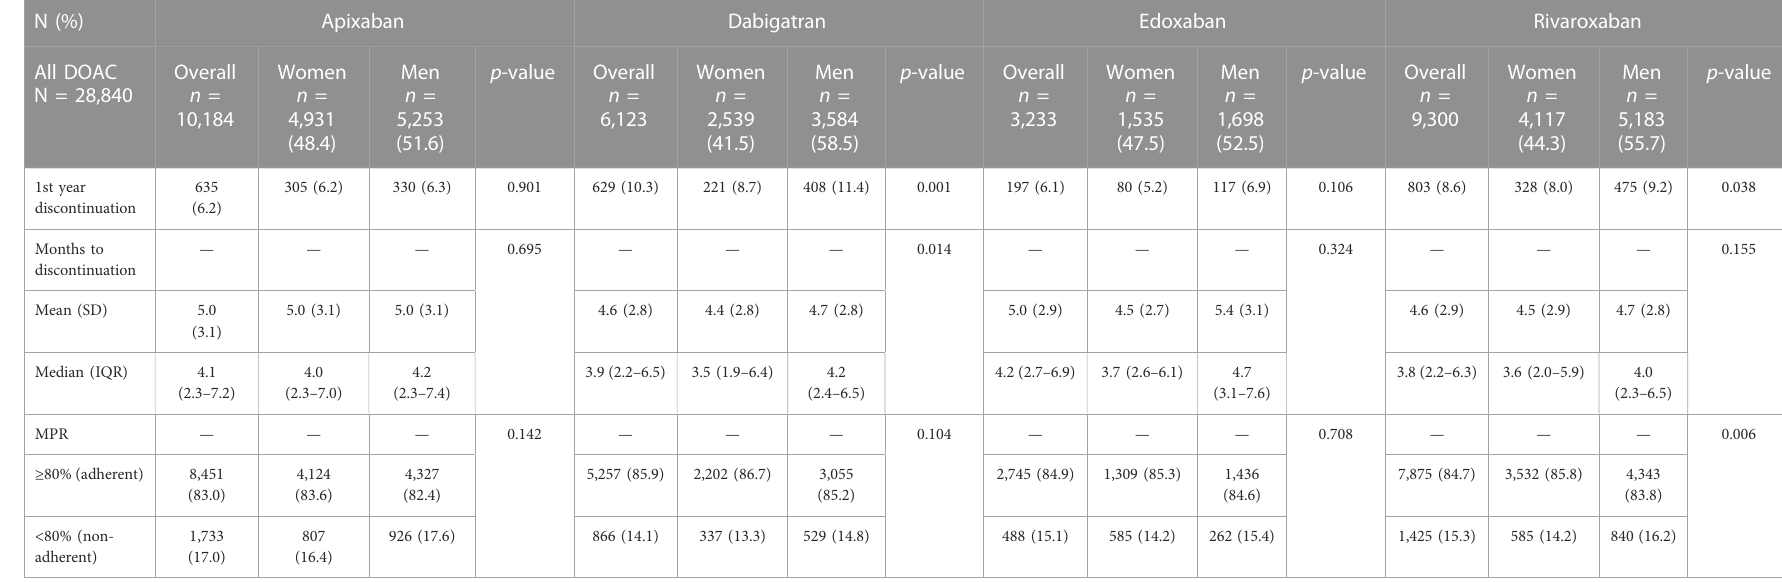
p-values for the comparison between genders. Chi-square test for categorical variables, and Kaplan-Meier curves to compare the restricted mean survival time to discontinuation (in